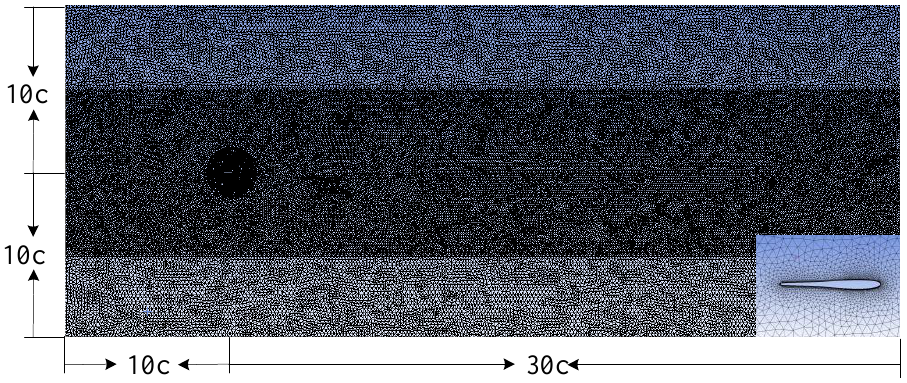
Figure 9. The definition of the boundary conditions.